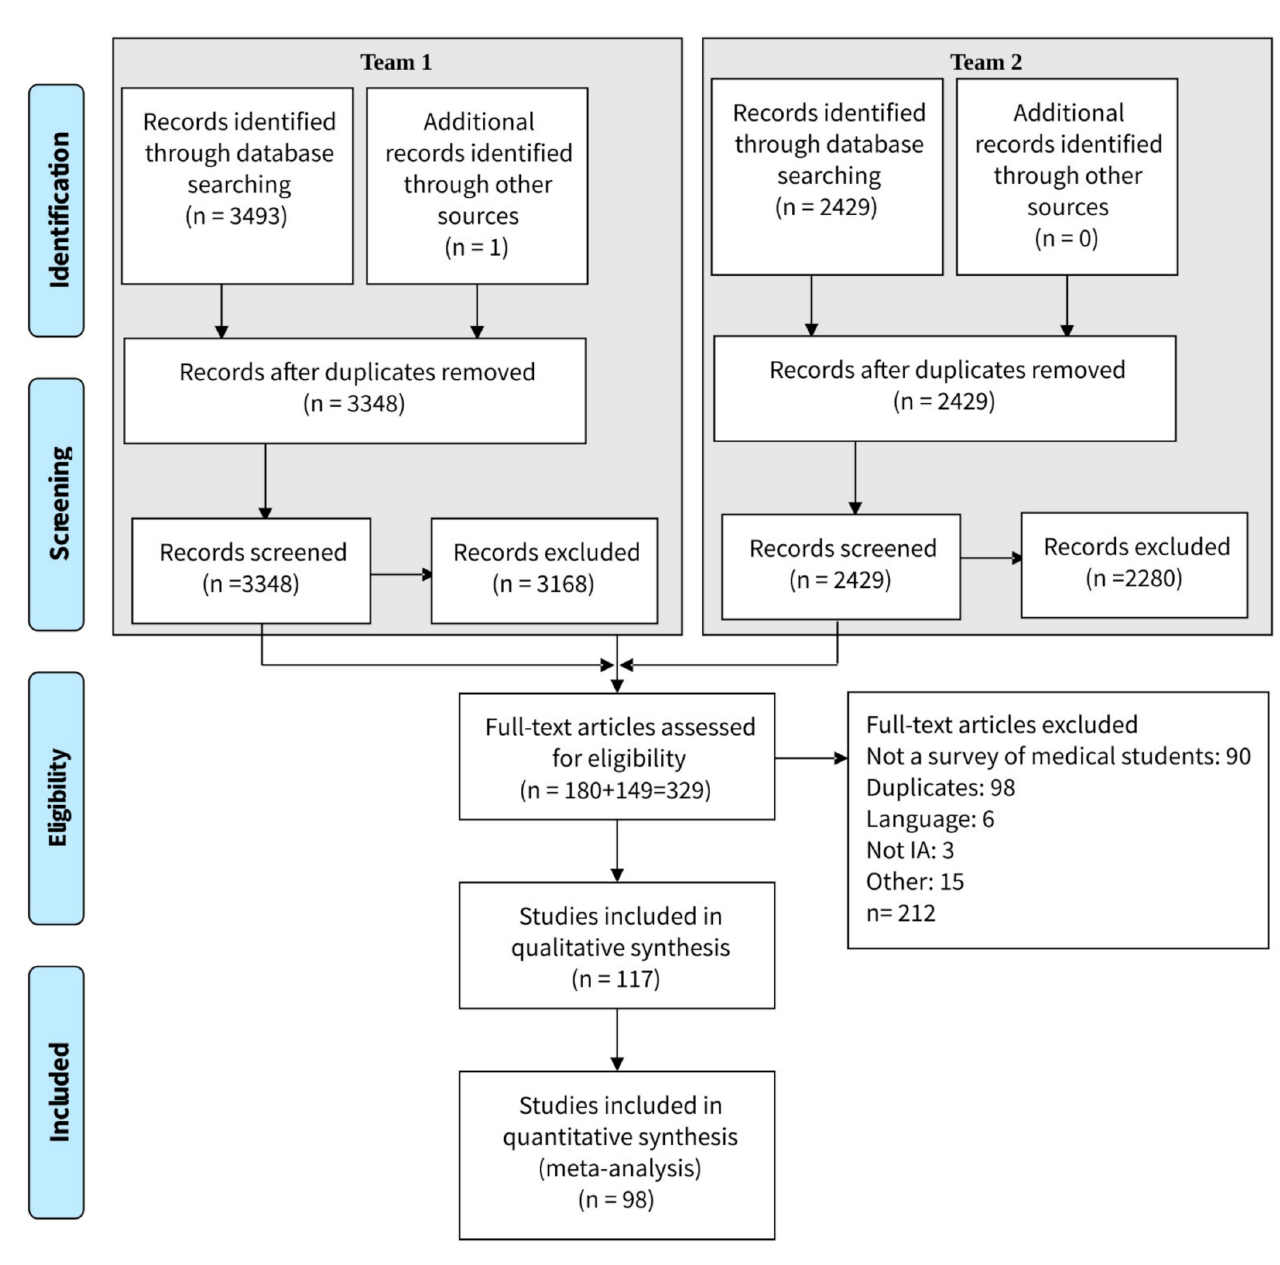
Figure 1. Flow chart of search details (Following PRISMA, 2009